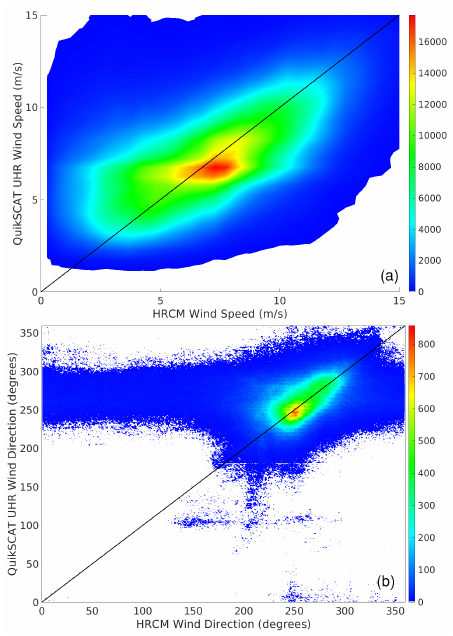
Figure 2. Density plots of QuikSCAT UHR wind speeds ( a ) and directions ( b ) plotted versus HRCM winds. A y = x line is included in each plot for reference.